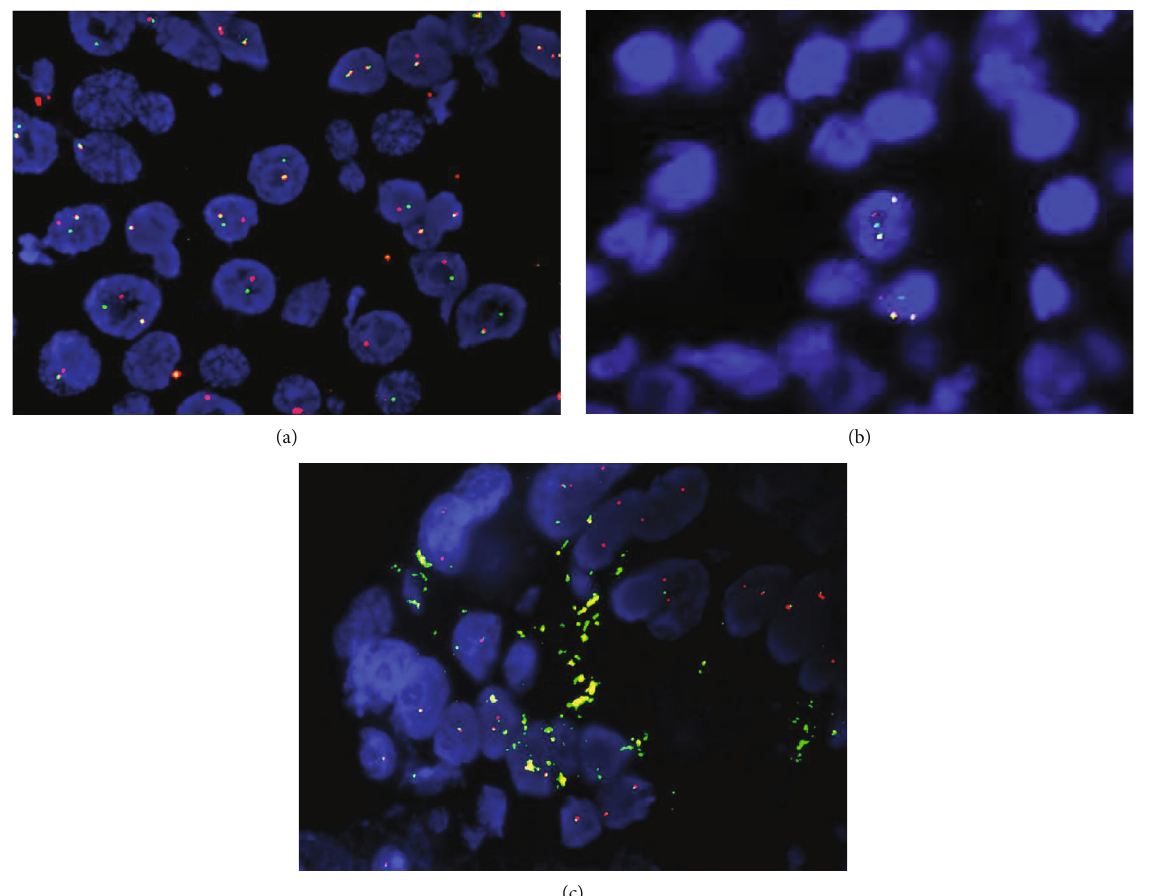
Figure 2: BCL1 FISH for splenic pleomorphic mantle cell lymphoma and esophageal adenocarcinoma. (a) The splenic mantle cell lymphoma shows red and green break-apart signals in 41% of cells by LSI BCL1 dual-color FISH probes (400x). (b) The lymphoma reveals BCL1/IGH dual-fusion signals in 65% of tumor cell nuclei with CCND1 and IGH gene copy numbers at 2 to 4 copies per cell (400x). (c) Esophageal adenocarcinoma exhibits no BCL1/CCND1 gene rearrangement in all the interphase tumor cells analyzed. However, aneuploidy with the single gene copy number of BCL1/CCND1 is observed in 24% of cells scored